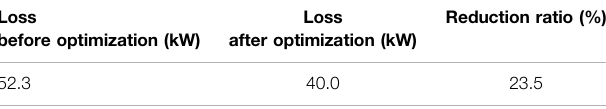
TABLE 2 | Comparison of active power losses before and after optimization.